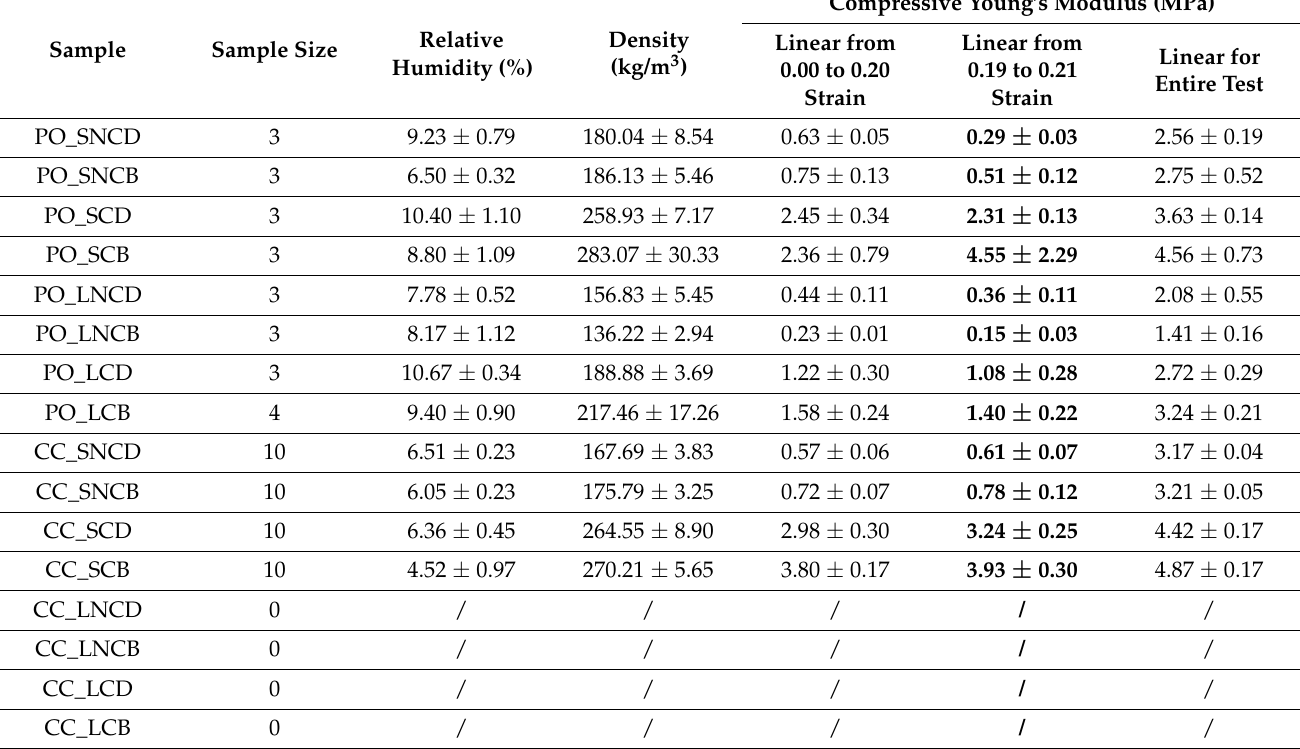
Table 2. This table shows relative humidity before testing, density, and Young’s moduli of the samples for the three different calculation techniques. Acronyms for each sample are labeled in Table